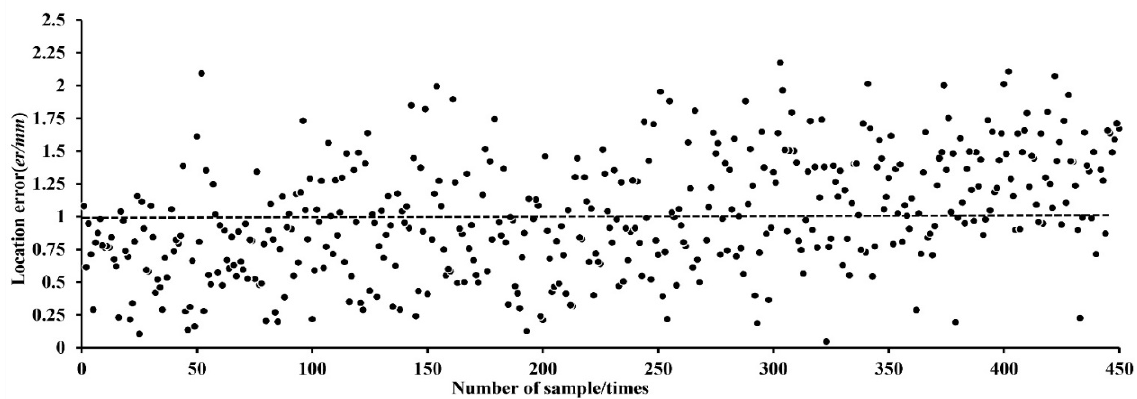
Figure 15. Probe positioning